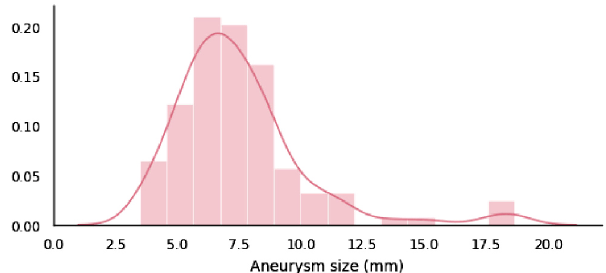
Fig. 5 Distribution of aneurysm sizes on our dataset (mean: 7.49 mm, SD: 2.72 mm; range: 3.48–18.66